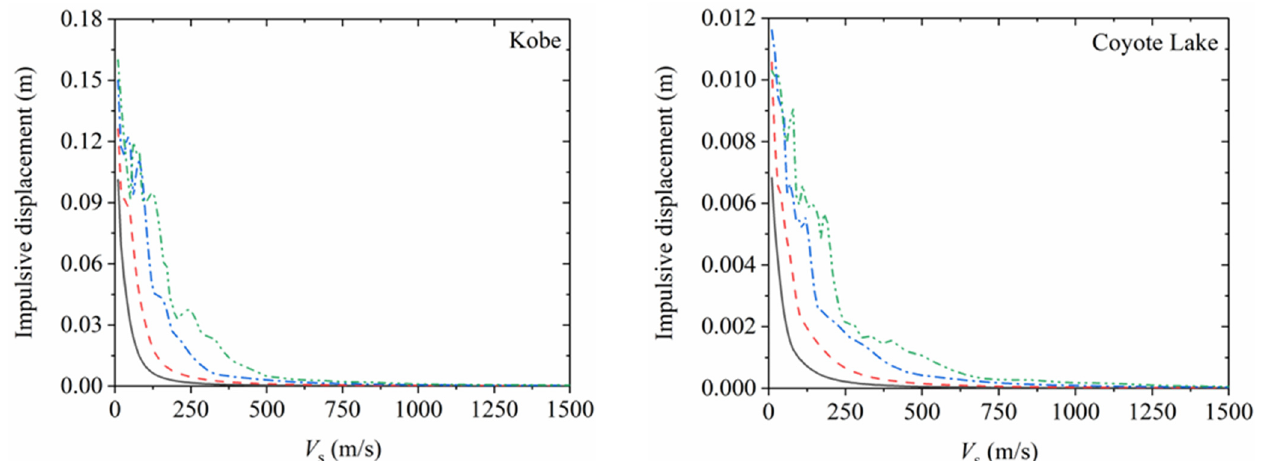
Figure 15. Ratio of the hydrodynamic shear under flexible soil to that under rigid soil for V s . Figure 18. Impulsive displacement of the tank for different shear velocities of soil V s .